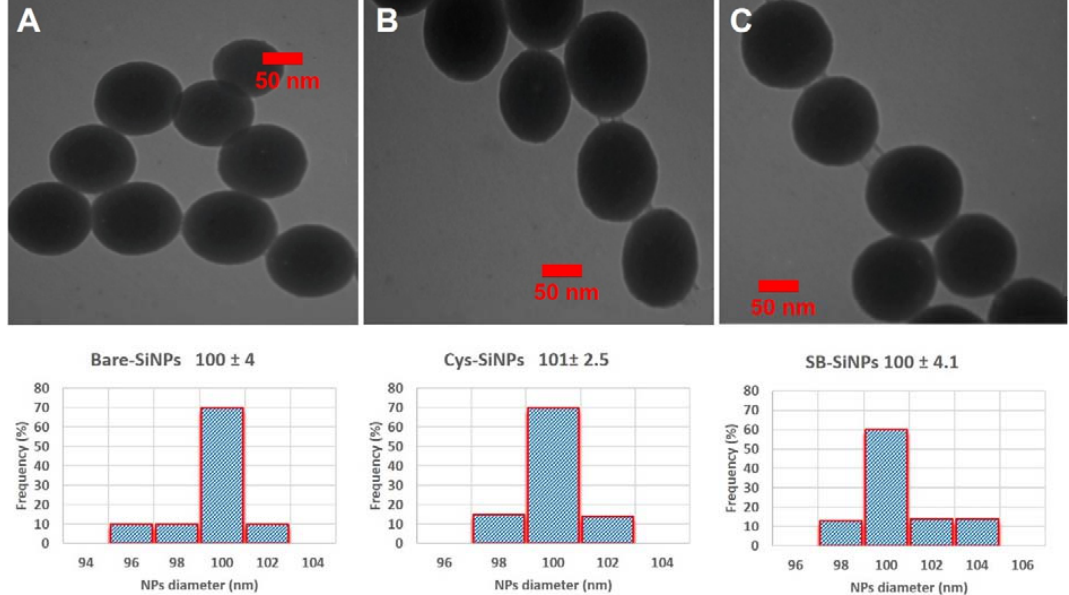
Fig. 2. TEM images for three type of SiNPs and corresponding size distribution plots for each type of NPs, unmodified and also zwitterionic functionalized SiNPs. (A) Bare-SiNPs (B) Cys-SiNPs (C) SB-SiNPs. Scale bars = 50 nm.